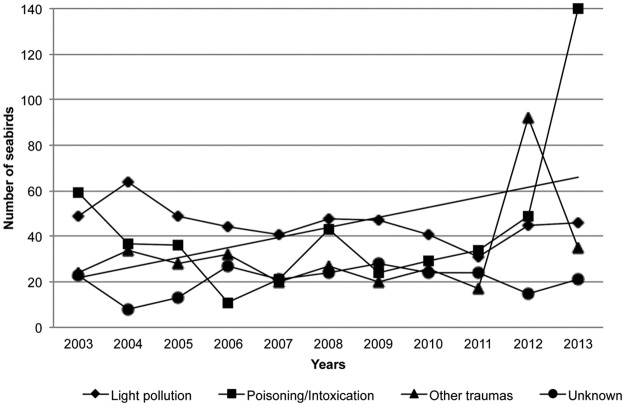
Annual variation of the four most frequent causes of seabird admissions at the Tafira Wildlife Rehabilitation Center (2003–2013).